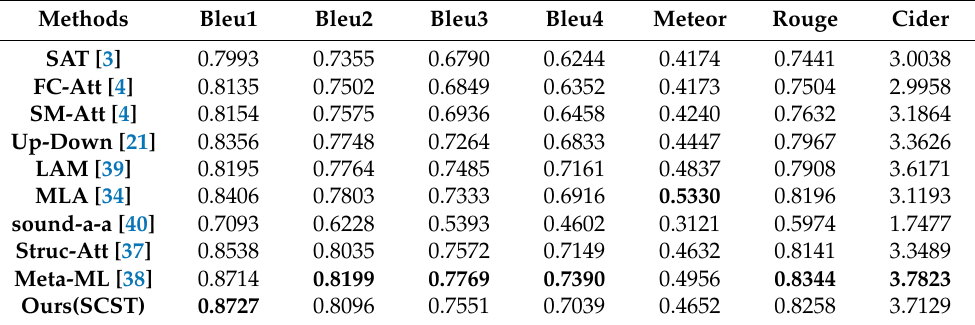
Table 2. Comparison of scores for our method and other state-of-the-art methods on the UCM- Captions data set